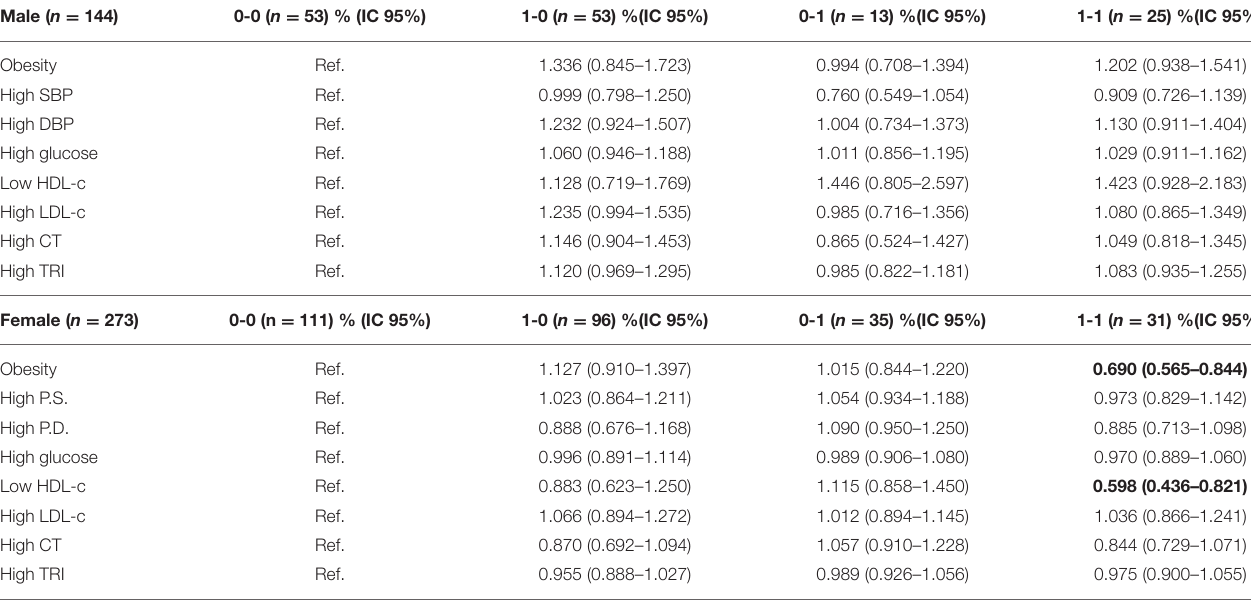
TABLE 3 | Adjusted association between participation in sports activities in youth and current physical activity and the trajectory of cardiovascular risk factors of public